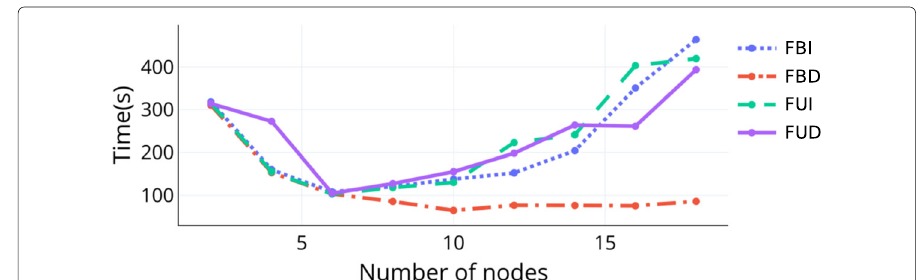
Fig. 5 Execution times for the first order MethodsFBI,FBD,FUI,FUD on CT data set